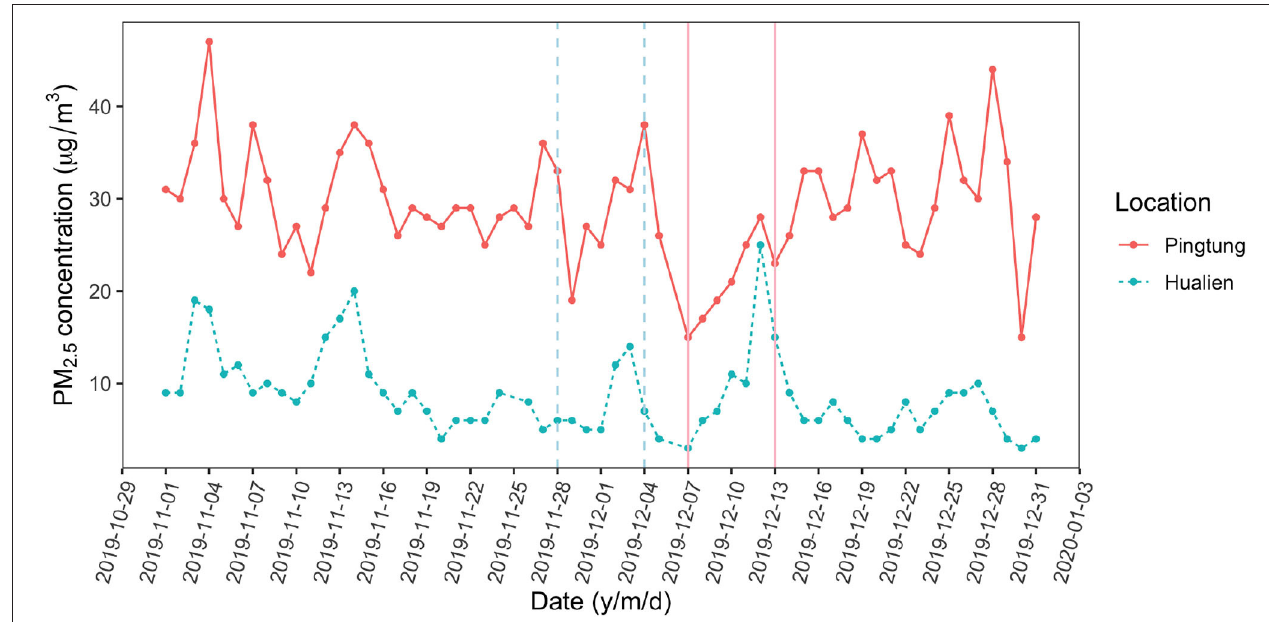
FIGURE 5 | Daily monitoring data of PM 2.5 in the fields while experiments were conducted (Source: Taiwan Air Quality Monitoring Network, Environmental Protection Administration, Taiwan). The solid line is the Pingtung site (expectedly more polluted) and the dashed line is the Hualien site (expectedly less polluted). The vertical lines indicate the periods while experiments were conducted (Hualien site: 28 November to 4 December 2019; Pingtung site: 7 December to 13 December